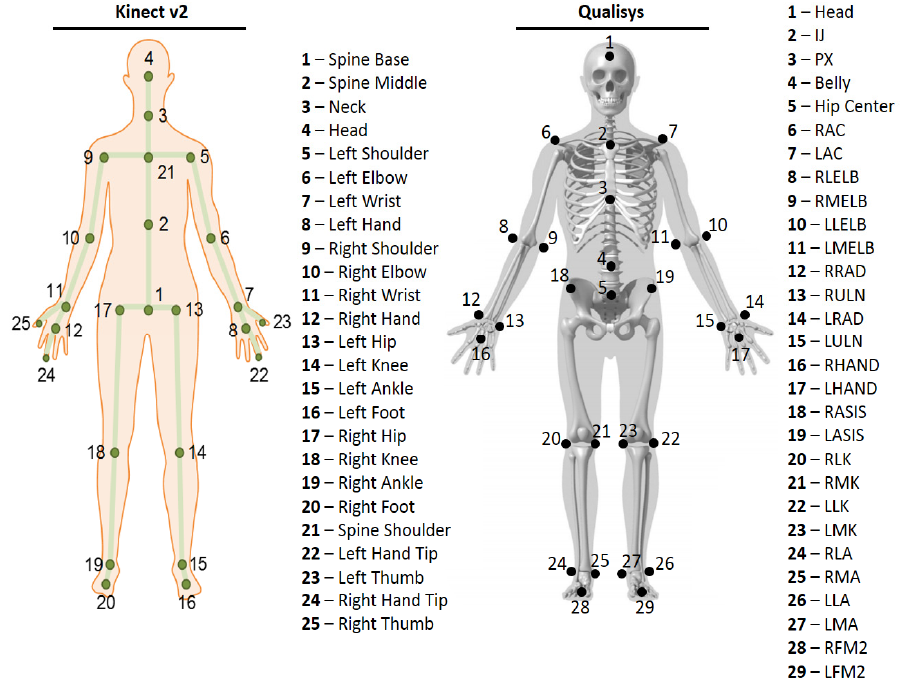
Figure 1. Body joints tracked by the Kinect v2, and retro-reflective markers placed at the subject’s body used by the Qualisys system.